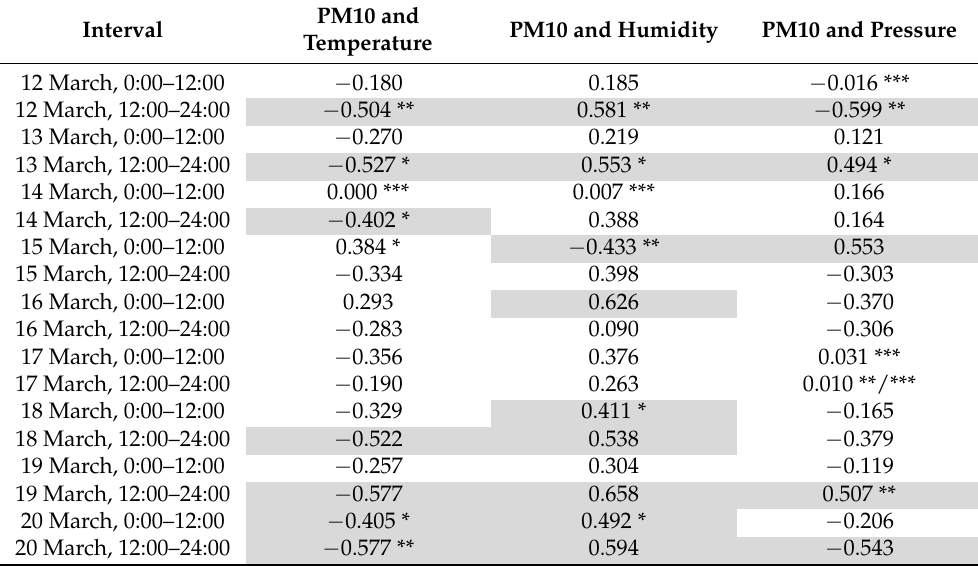
Table 12. Correlation between mass concentration of PM10 and temperature, humidity, pressure: garden measurement.